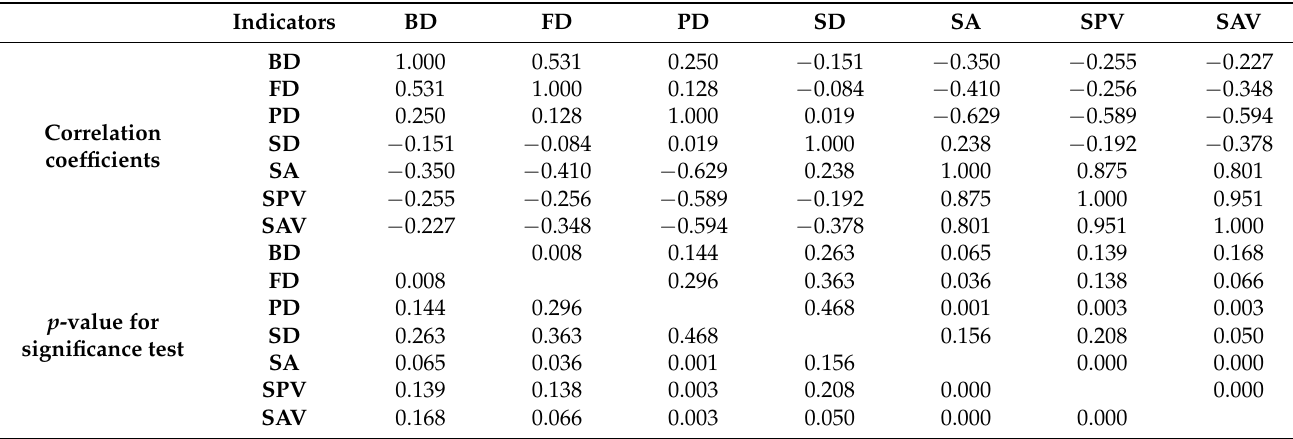
Table 3. Correlation matrix of eye movement indicators.